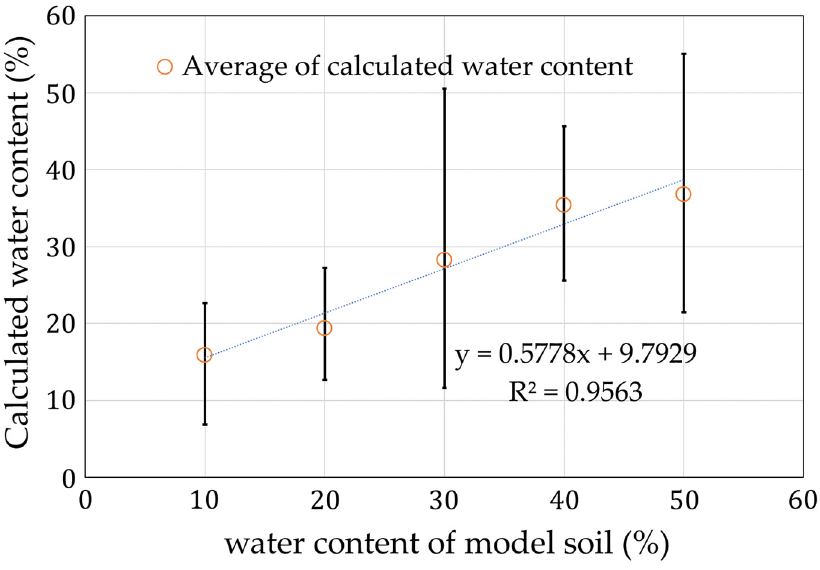
Figure 17. Results of the water content calculations.